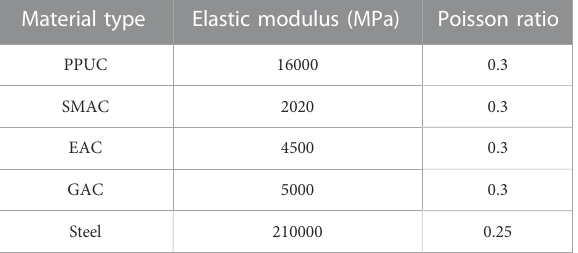
TABLE 6 Material parameters of the pavement structure model. Material